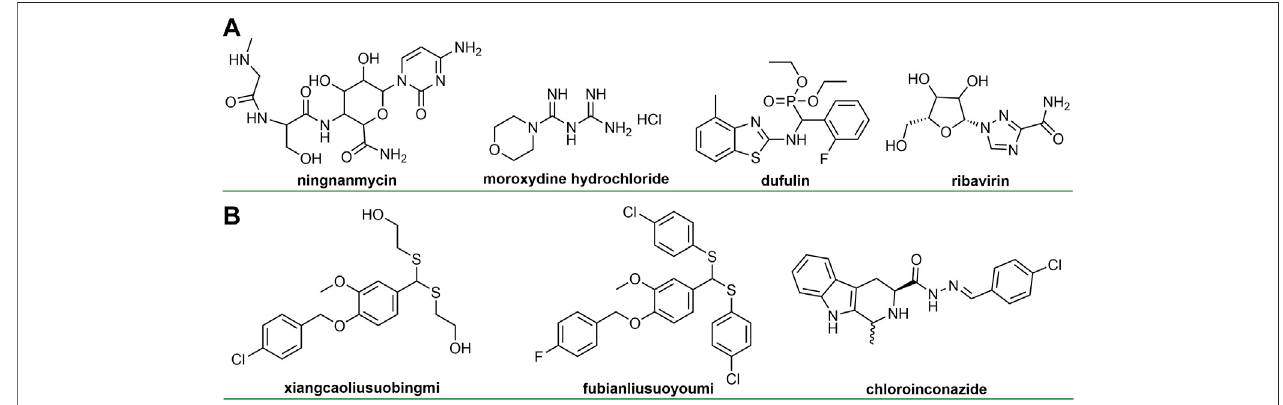
FIGURE 1 | Chemical structures of commercialized (A) or under development antiviral agents (B)